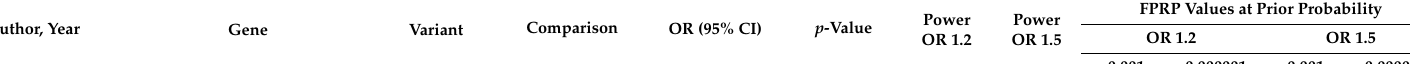
Table 2. Re-analysis results of gene variants with genome wide statistical significance ( p -value < 5 × 10 − 8 ) and borderline statistical significance (5 × 10 − 8 ≤ p -value < 0.05) in GWAS